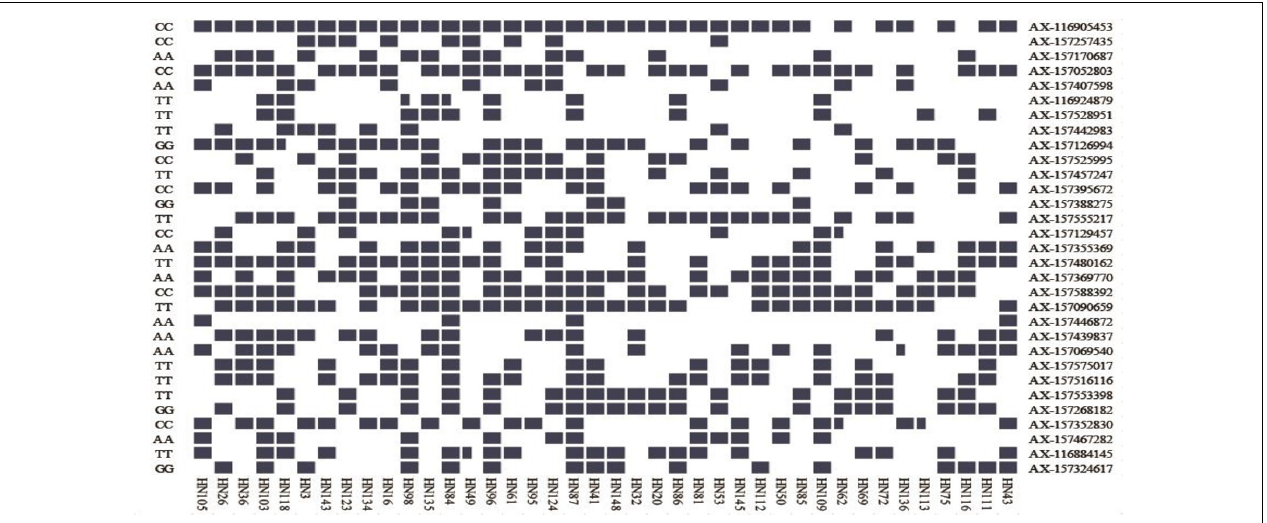
FIGURE 6 | Heat map of the superior allele distribution for the 31 common QTNs in the 40 smaller and larger-seed lines. Blue and white colors represent superior and inferior alleles, respectively.